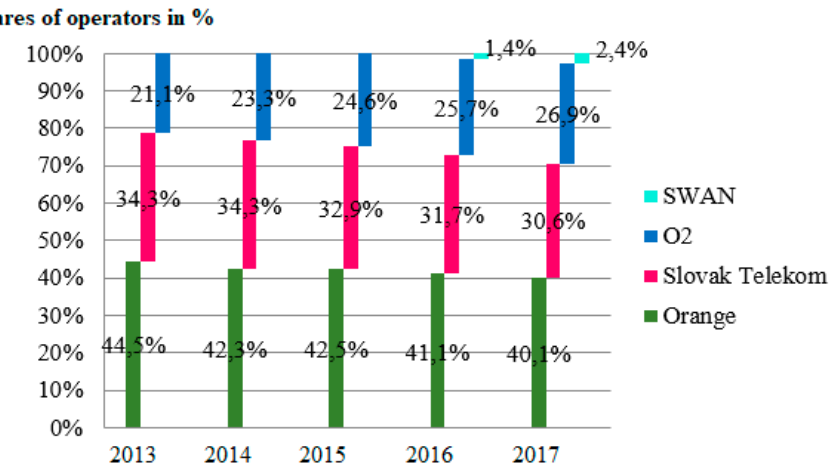
Figure 3. Shares of mobile operators based on number of active customers.